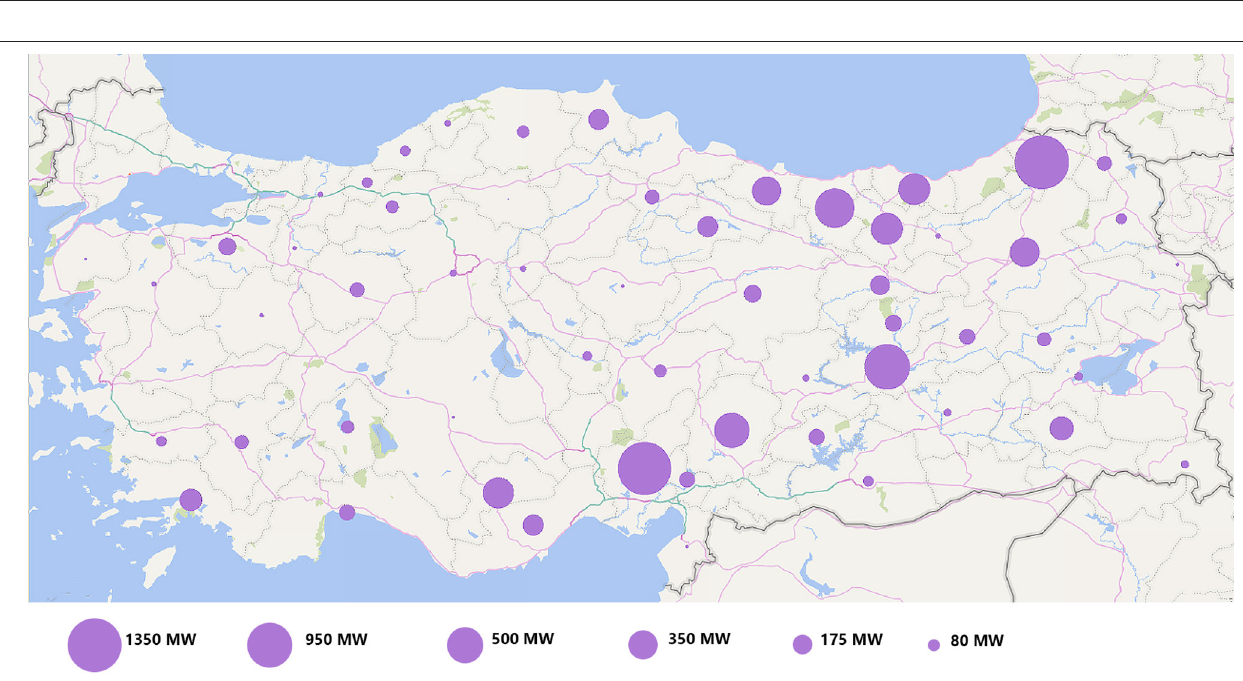
FIGURE 6 | Environmental conflicts against the coal power plants, Turkish Map of Environmental Justice, March 2017.